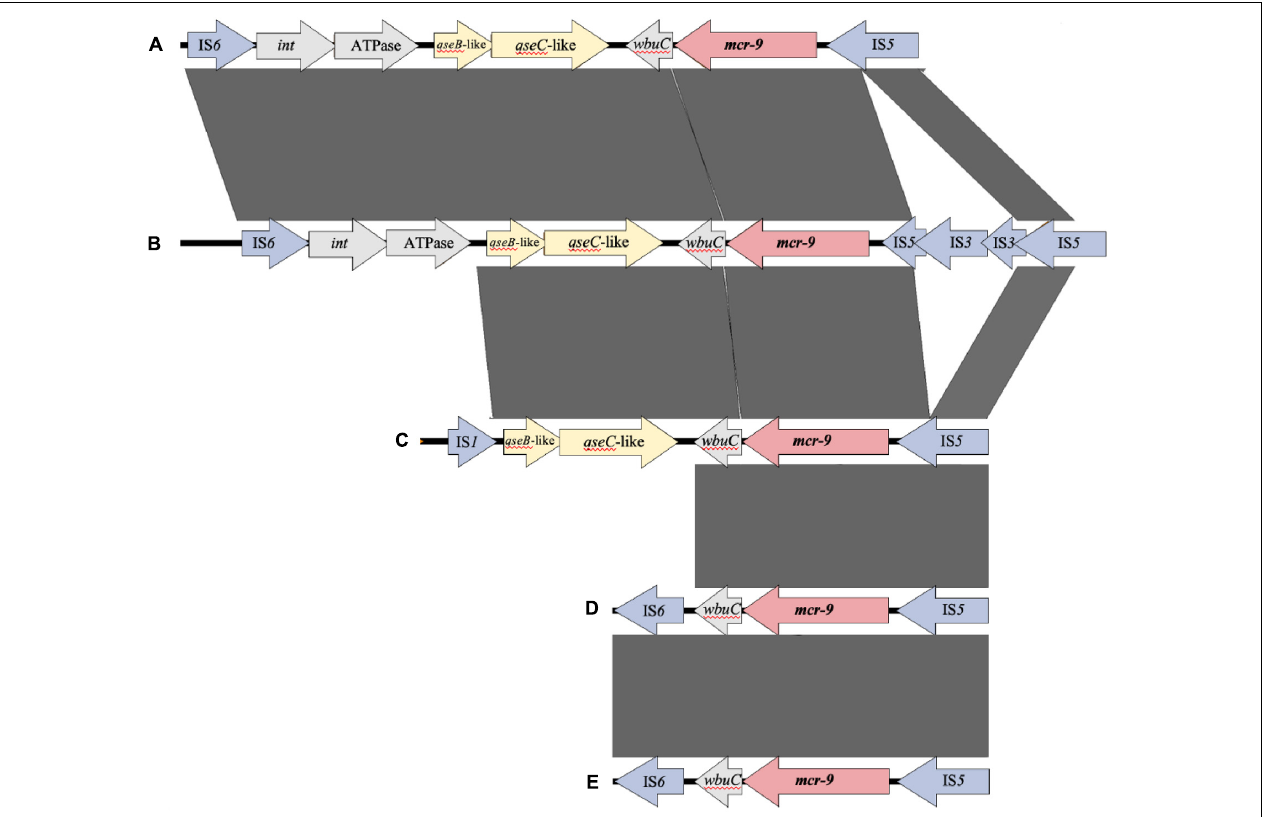
FIGURE 4 | Comparison of the structure around the mcr-9 gene in each isolate. (A) Leclercia sp. (accession number CP031102), (B) Enterobacter kobei THUN627 (this study), (C) Salmonella enterica (accession number CP029037), (D) Enterobacter cloacae (accession number CP020529), and (E) Escherichia coli THUN648 (this study) and Klebsiella pneumoniae THUN262 (this